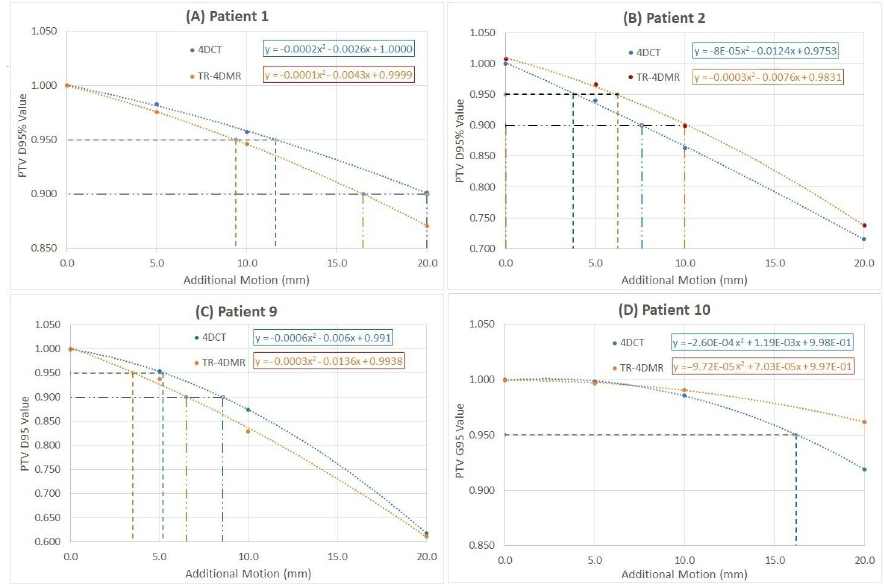
Figure 3. Four examples of the breaching points (PTV D95%) as a function of increased tumor motion amplitudes with quadratic fittings with the equations. Both 4DCT-based (blue) and TR-4DMRI-based (orange) breaching points for patients 1 ( A ), 2 ( B ), 9 ( C ), and 10 ( D ) are shown. For patient 10, only the first breaching point on the 4DCT set can be found.